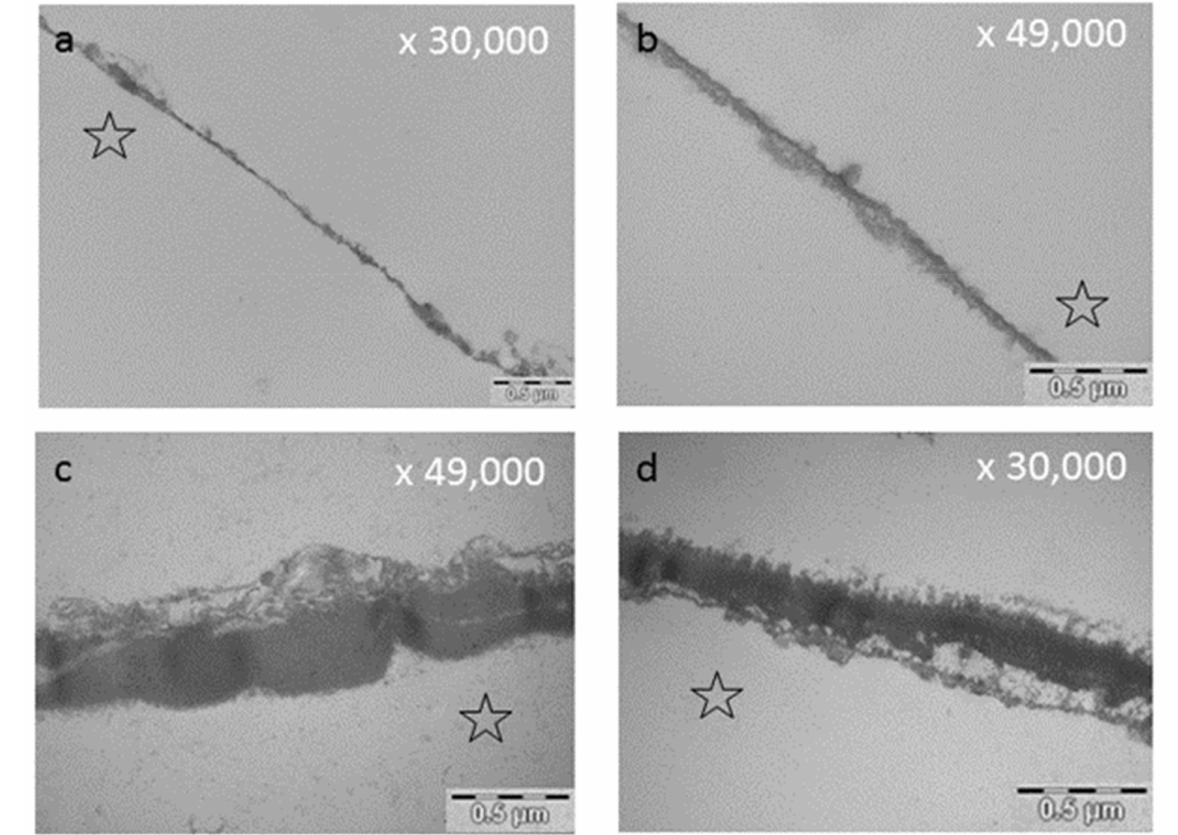
Figure 7. Representative TEM images of the pellicle ultrastructure after initial rinsing with different polyphenolic agents followed by 2 h of intraoral exposure. Rinsing with polyphenolic compounds leads to an increased pellicle thickness and density. The former enamel site was marked with an asterisk. ( a ) Native pellicle, control, no rinsing, intraoral exposure: 2 h, ( b ) Control, effect of CHX, intraoral exposure: 2 h, ( c ) Leaves of R. nigrum, watery plant extract 8 mL, 10 min rinsing, intraoral exposure: 2 h. For details consider Weber et al. (2015) [178], ( d ) Hamamelis (bark), 0.2 mg/8 mL, 10 min rinsing, intraoral exposure: 2 h. For details consider Kirsch et al. (2020)